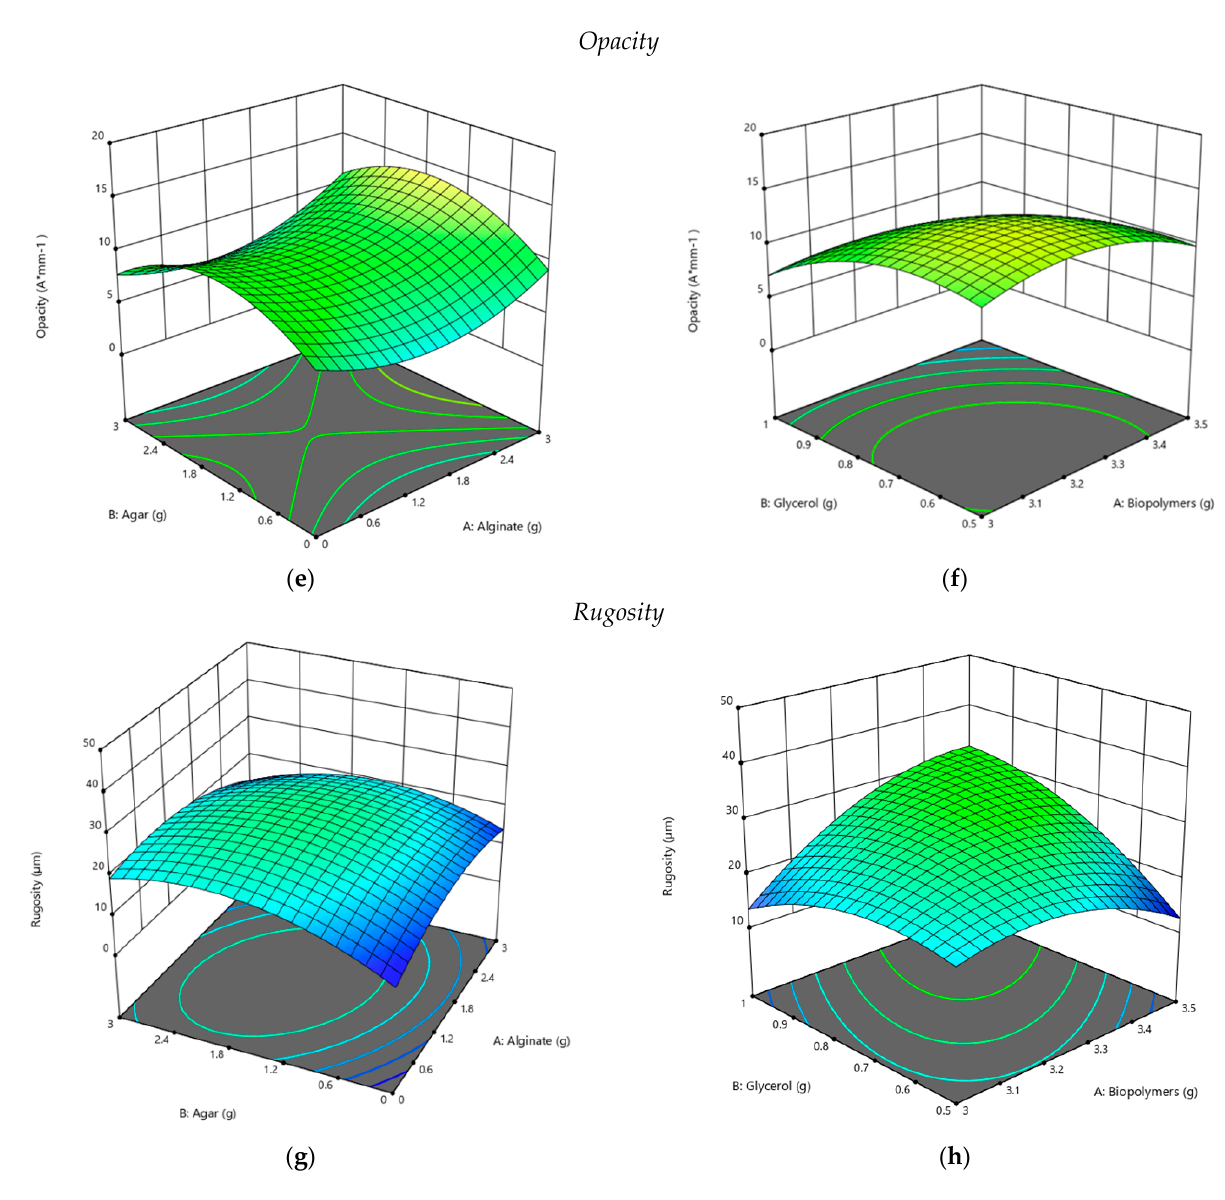
Figure 6. 3 D Surface optimization of the films regarding the agar/alginate mass on water solubility ( a ), thickness ( c ), opacity ( e ), rugosity ( g ), and biopolymers-plasticizer mass on water solubility ( b ), thickness ( d ), opacity ( f ), and rugosity ( h ).